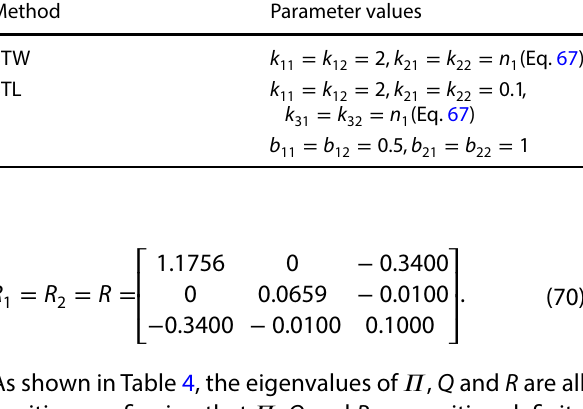
Fig. 7 Plots of sliding surface vectors s 1 , s 2 and external torques 𝜏 1 , 𝜏 2 (SOSMC) Table 5 Parameter values of STW and STL for comparison with SOSMC Method Parameter